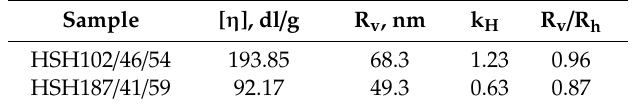
Table 4. Viscometry results of the HSH triblock copolymers in n-heptane.